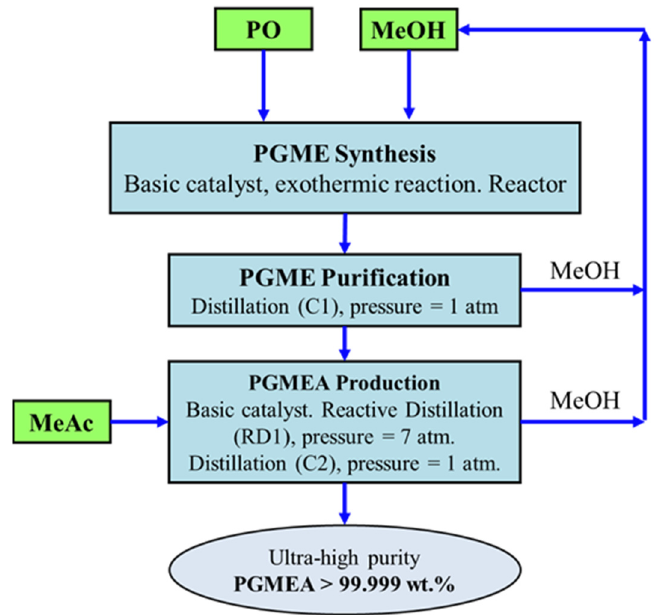
Figure 1. Schematic base case diagram of the intensified PGMEA production process.